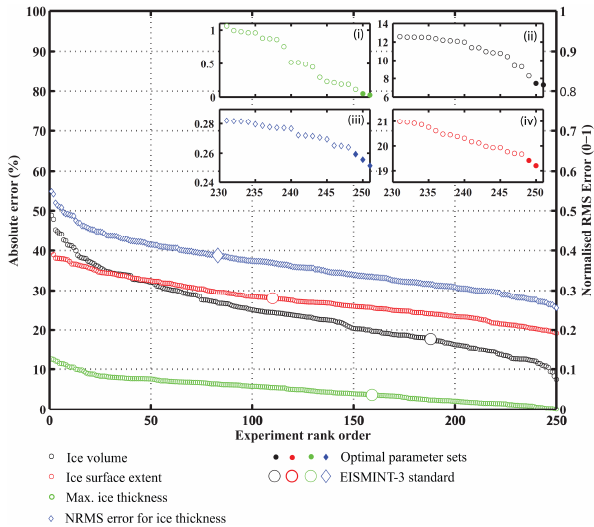
Fig. 8. Ranking of LHS experiments for ice volume, ice surface Figure 8. Ranking of LHS experiments for ice volume, ice surface extent and 3 extent and maximum ice thickness according to absolute error (left maximum ice thickness according to absolute error (left) and NRMSE for ice 4 axis) and NRMSE for ice thickness (right axis). The experiments thickness (right). The experiments rank from least agreement (1) to the closest 5 rank from least agreement (1) to the closest agreement with observa- agreement with observation (251). Observations are taken from Bamber et al. (2001) 6 tion (251). Observations are taken from Bamber et al. (2001) on the on the 20 km resolution grid. The larger symbols represent the rank position of the 7 20km resolution grid. The larger symbols represent the rank posi- tion of the standard EISMINT-3 experiment. The inset graphs show standard EISMINT-3 experiment. The inset graphs show the optimal experiments 8 the optimal experiments zoomed in for ranking from 230 to 251 for zoomed in for ranking from 230 to 251 for (i) maximum ice thickness, (ii) ice volume, 9 (i) maximum ice thickness, (ii) ice volume, (iii) NRMSE for ice (iii) NRMSE for ice thickness and (iv) ice surface extent. The y-scale for each inset is 10 thickness and (iv) ice surface extent. The y-scale for each inset is independent for each diagnostic in order to see the change in gradient more clearly. 11 independent for each diagnostic in order to see the change in gra- Filled circles/diamonds represent the optimal parameter sets for reproducing the 12 dient more clearly. Filled circles/diamonds represent the optimal modern day GrIS. 13 parameter sets for reproducing the modern day